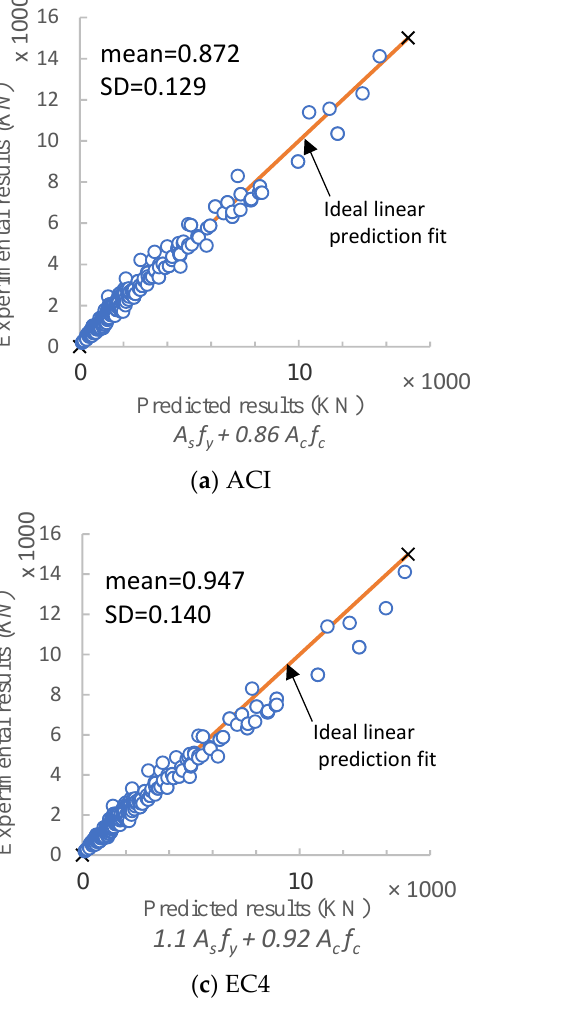
Figure 7. Performance of the first modified approach of the standard formulations.